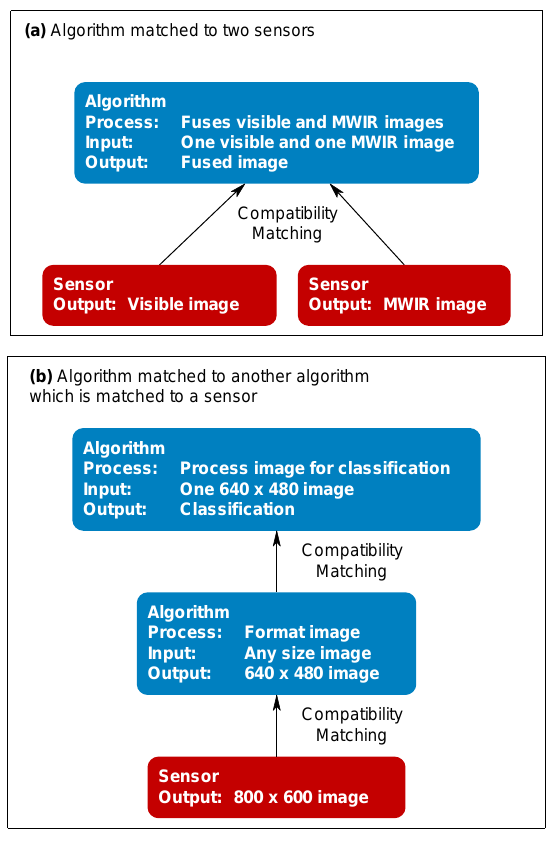
Figure 3. (a) Algorithm, which requires data from two sensor systems, matched to two compatible sensor systems. (b) Algorithm matched to a compatible algorithm, which is also matched to a compatible sensor